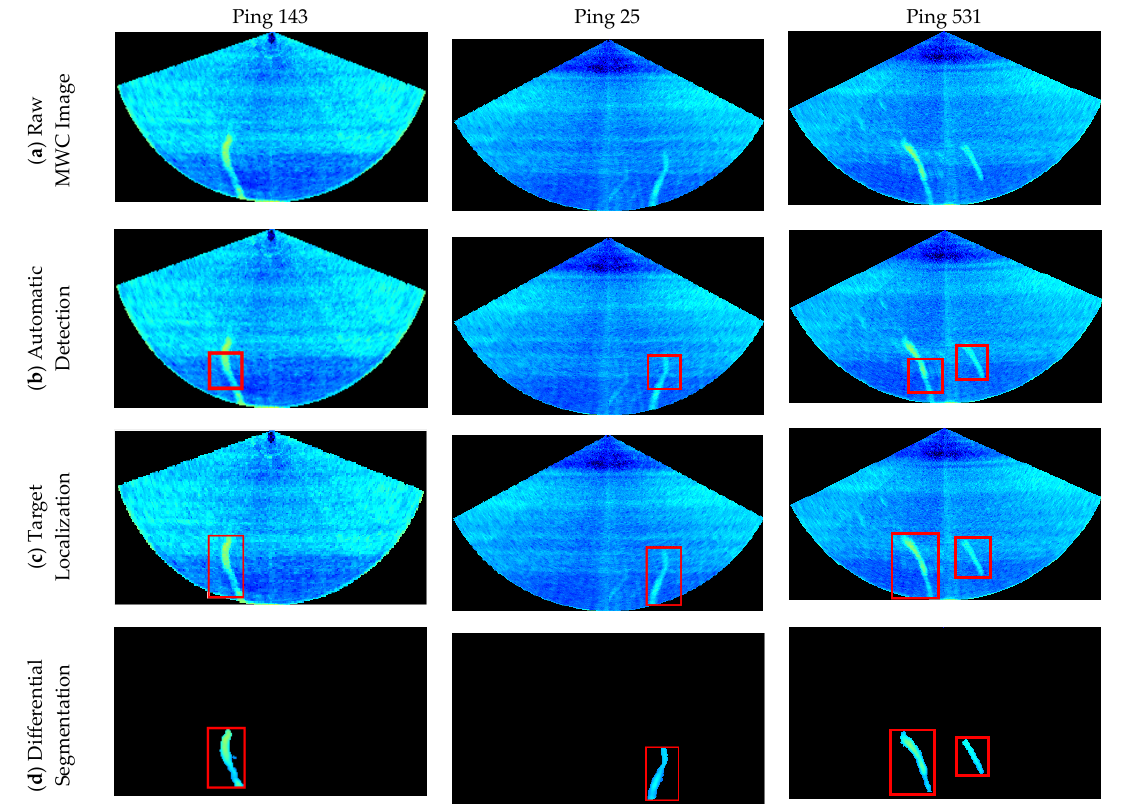
Figure 18. Three gas plumes detected, localized and segmented from these deep-water MWC images by the proposed method. ( a ) Raw MWC images; ( b ) gas plumes detected by the proposed automatic detection algorithm; ( c ) the exact target-box locations obtained by the target localization algorithm; ( d ) gas plumes segmented by the differential segmentation algorithm and morphological constraint algorithm.